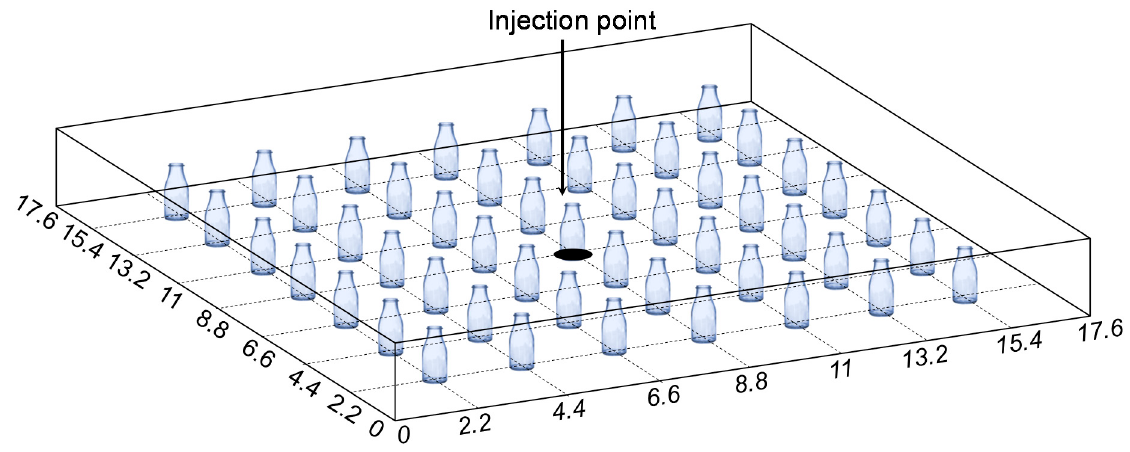
Figure 1. Ion precipitation distribution test device diagram.